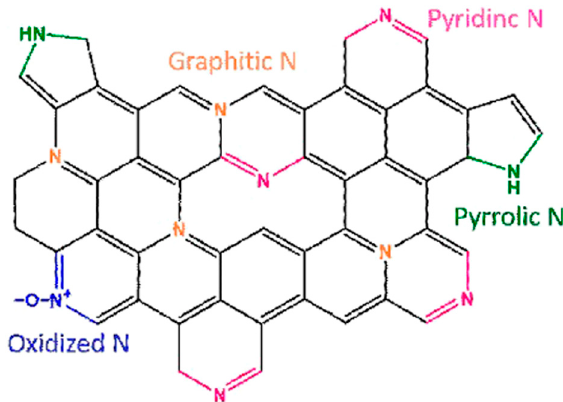
Figure 1. The four nitrogen doping configurations usually observed on carbon catalysts.